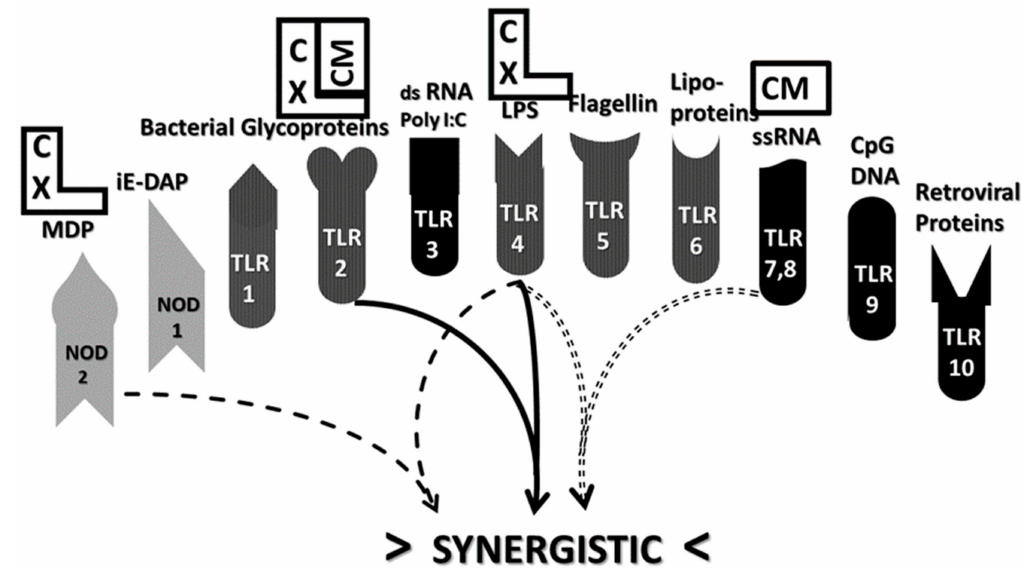
Figure 8. Schematic diagram showing the toll-like receptor (TLR) and nucleotide-binding oligomerization domain-containing protein (NOD) synergisms (Figure 7) that are expressed in autoimmune myocarditis (AM) and its animal model, experimental autoimmune myocarditis (EAM). These are illustrated here by the model using coxsackievirus (CX) and cardiac myosin (CM) as initiators, though the same sets of TLR / NOD activations occur in other EAM models and AM itself (Tables 1 and 2). See Figure 1 for TLR and NOD-activator